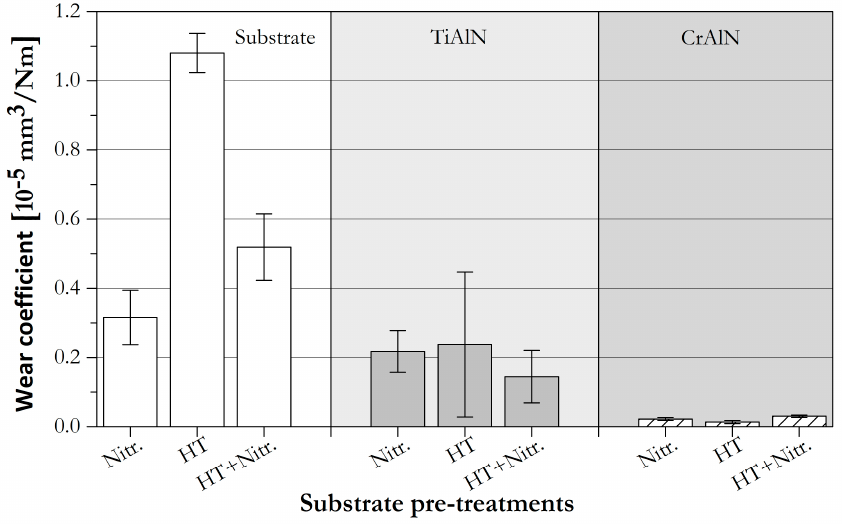
Figure 11. Wear coe ffi cients of the substrates after pre-treatments and of the Figure 11. Wear coefficients of the substrates after pre-treatments and of the coatings.